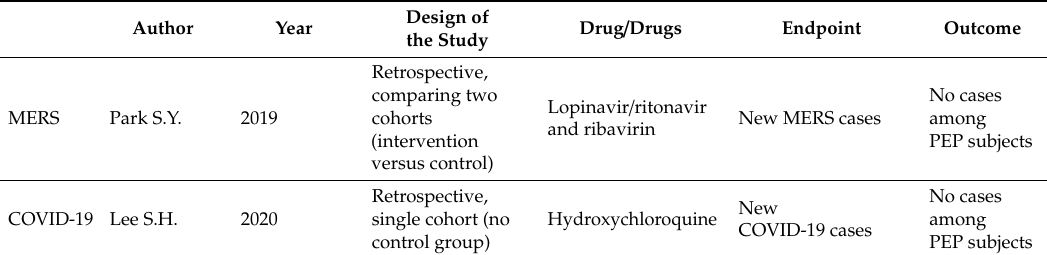
Design of Drug / Drugs Endpoint Outcome the Study Retrospective, comparing two No cases Lopinavir / ritonavir cohorts New MERS cases among and ribavirin (intervention PEP subjects versus control)